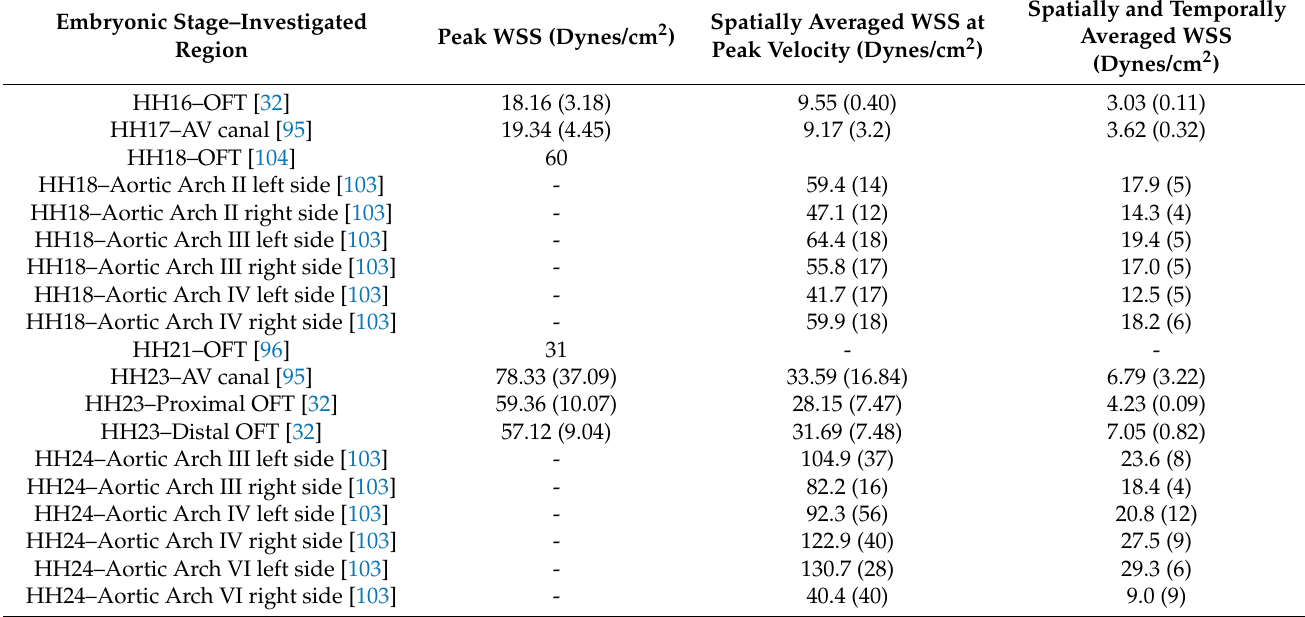
Table 1. Wall shear stress (WSS) levels in normal chicken embryos for various developmental stages. Values in parentheses are standard deviations (OFT: outflow tract, AV canal: atrioventricular canal, RVOFT: right ventricle outflow tract, LVOFT: left ventricle outflow